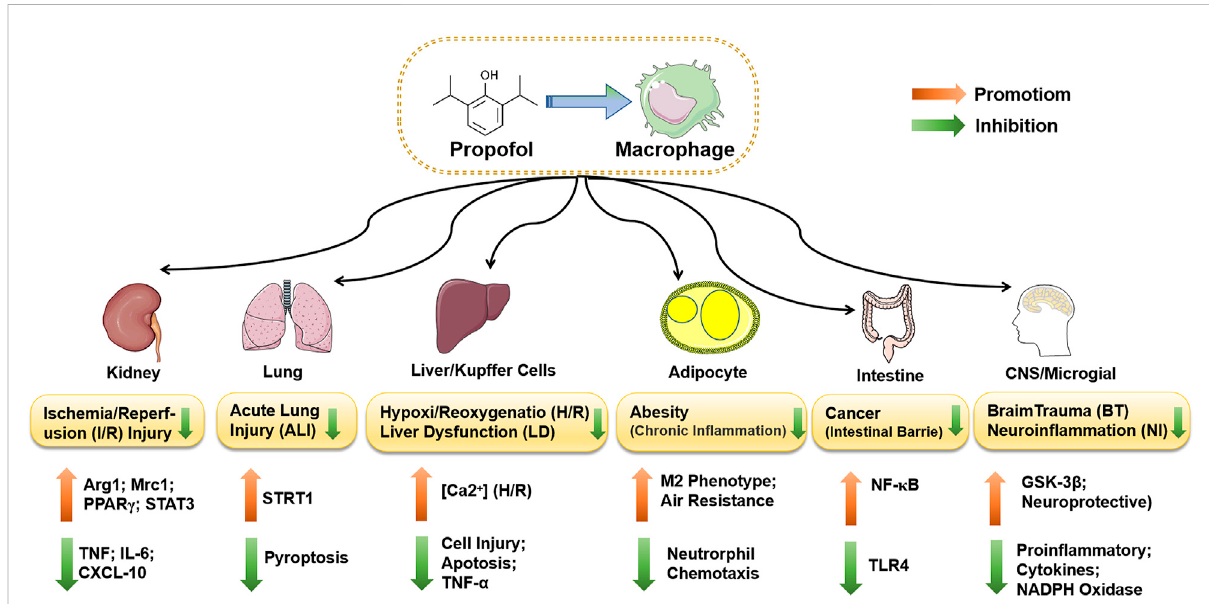
FIGURE 4 Thefunctions ofpropofol-regulatedmacrophagesindifferentdiseases.PropofolsuppressestheexpressionofSTRT1byinhibitingIL-1 β andIL- 18 in rat alveolar macrophages or lung tissue, which inhibits cell pyroptosis and attenuates ALI induced by rl/R. Propofol inhibits the activation of caspase-3 and the apoptosis of hepatocytes and alleviates LPS-induced liver dysfunction. During H/R, the inhibitory effect may be induced by the increasein[Ca2 + ]iinKupffercells.PropofolalsoinhibitstheTLR/NF- Κ BpathwayviamicroRNA,reducesthereleaseofin fl ammatoryfactors,and protects the intestinal mucosal barrier of colorectal cancer. Propofol partially protects microglia by downregulating TLR4 and inducing inactivation of GSK-3 β , which inhibits the release of in fl ammatory factors and reduces LPS-induced neuroin fl ammation (NI). Neuroprotection after brain trauma (BT) may result from propofol reducing the expression of two key components of NADPH oxidase, P22phox and